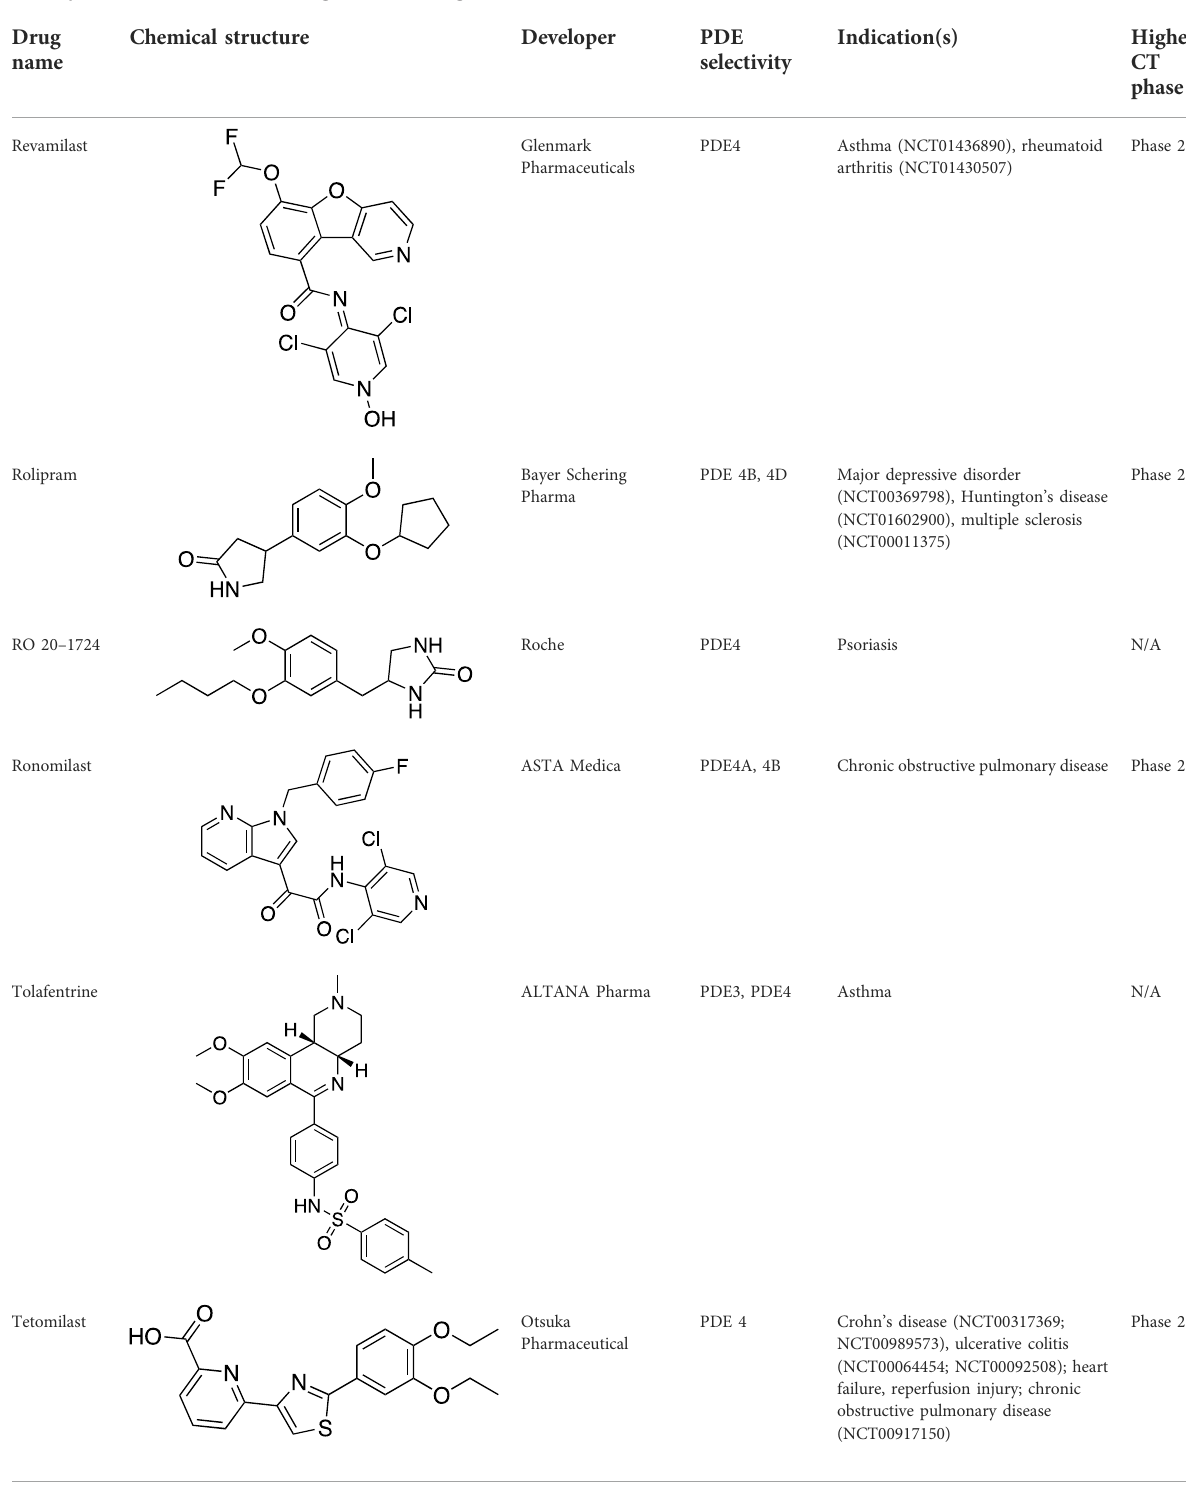
TABLE 6 ( Continued ) Investigational PDE inhibitors in discontinued or unknown clinical development. This table provides a summary on the investigational PDE inhibitors that have been evaluated clinically, but whose development is either discontinued as of 2022 or is otherwise unknown. The aggregated data on clinical trials is listed as per the ClinicalTrials.gov, the EU Clinical Trials register and PubMed databases and/or the developers ’ websites. Chemical structures are derived from the PubChem database(Kim et al., 2021). Developer names are listed according to the relevant studies. Development status is listed according to the AdisInsight database